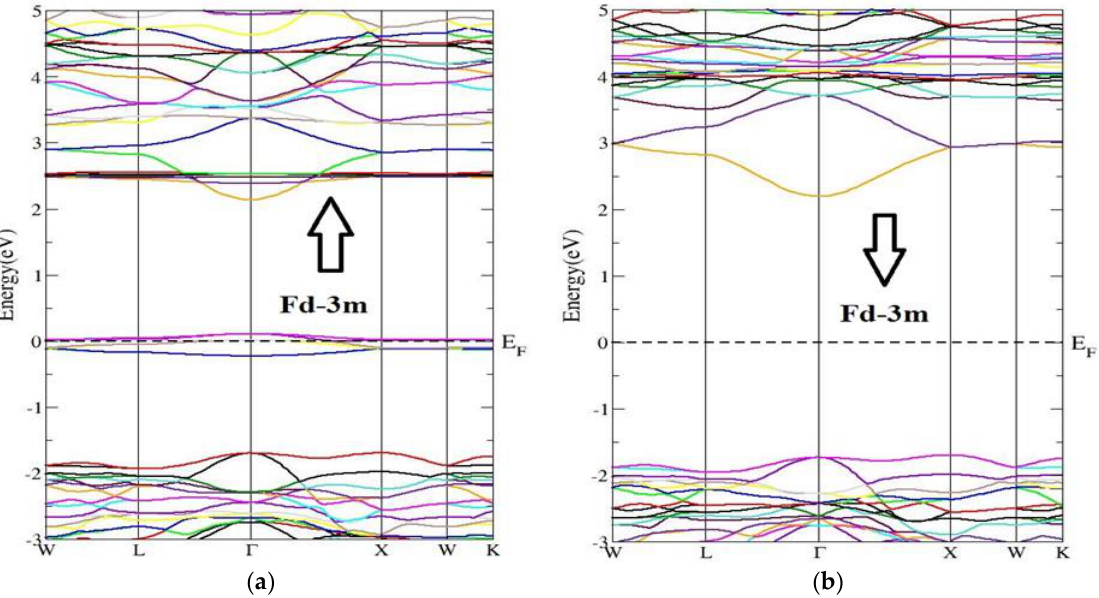
Figure 2. Energy band structure of Nd 2 Zr 2 O 7 compound in Fd-3m phase for ( a ) the spin-up direction ( ↑ ) and ( b ) spin-down ( ↓ ) direction.